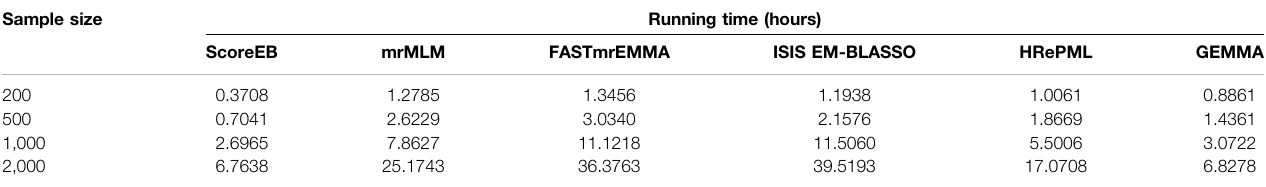
TABLE 4 | Comparison of running time at different sample size with ScoreEB, mrMLM, FASTmrEMMA, ISIS EM-BLASSO, HRePML and GEMMA methods a . Sample size